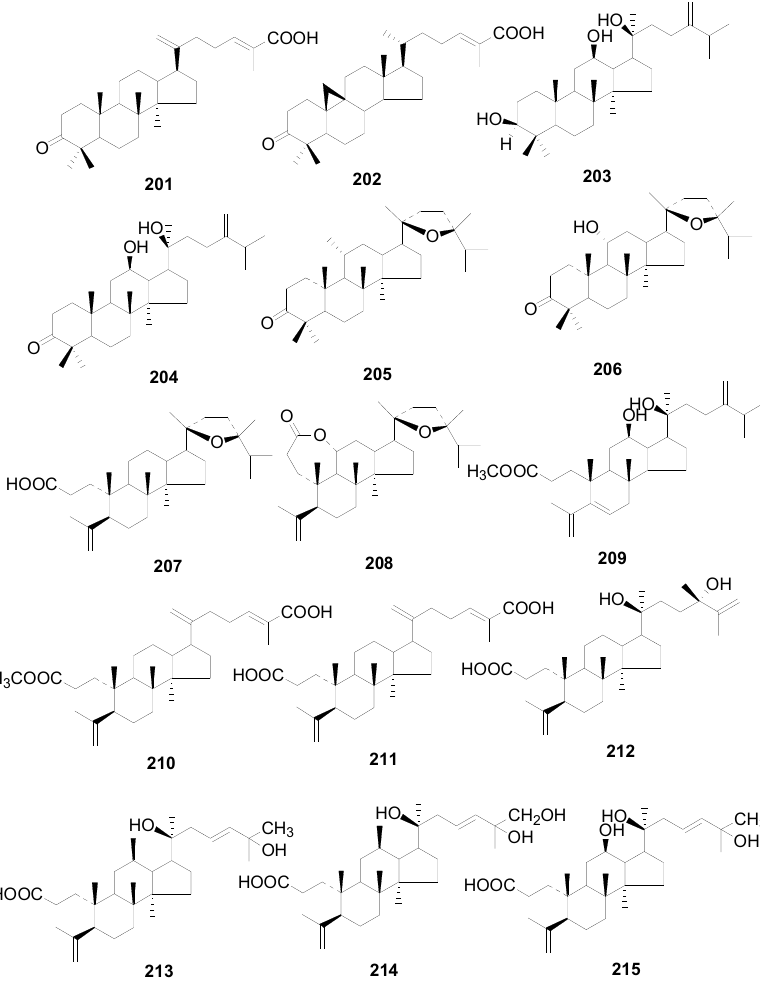
Figure 9. Structures of compounds 201 – 215 . Table 14. Structures of compounds 216 – 223 .